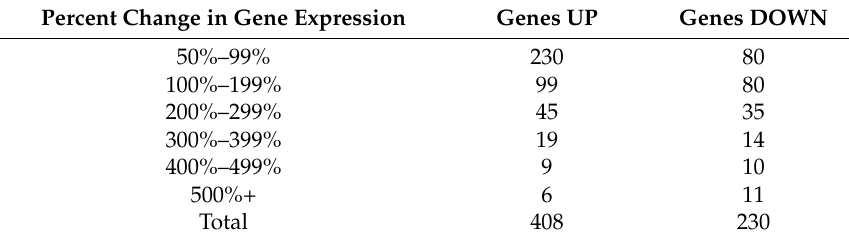
Table 11. Distribution of Genes Affected by GHK and Associated with